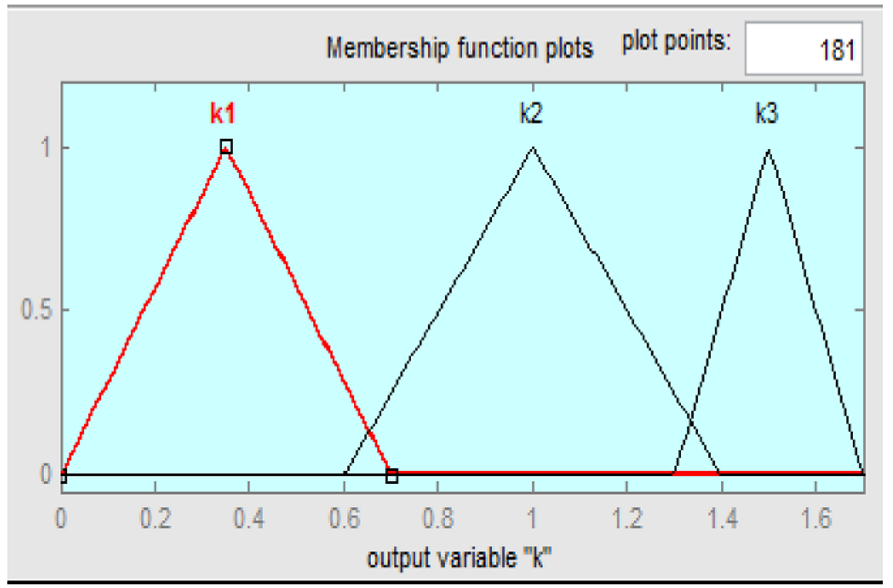
Figure 9. Fuzzified gain factor